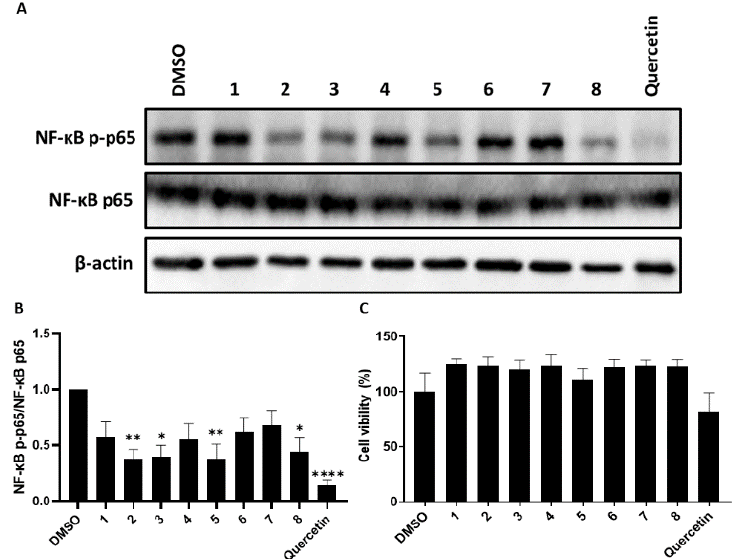
Figure 5. The SARS-CoV-2 pseudovirus-stimulated THP-1 macrophages were treated with individual compounds (25 µ M) for 18 h, and each of the protein lysates were collected for Western blotting. DMSO was used as a solvent control. ( A ) Phosphorylated NF- κ B p65 and NF- κ B p65 were deter- mined by indicated antibody. GAPDH was used as a loading control. ( B ) Densitometric analysis of Western blots was performed by Image J. Three individual experiments were performed. The ratio of phosphorylated NF- κ B (p-p65) versus the expression level of NF- κ B (p65) was presented. ( C ) The THP-1 macrophages were treated with compounds (25 µ M) for 48 h. Cell viability was determined by MTS assay. The data show the means ± SD of three independent experiments and were analyzed by Prism (www.graphpad.com, accessed on 2 November 2022). Statistic comparison among the groups was performed by one-way ANOVA (* p < 0.05, ** p < 0.01, **** p <